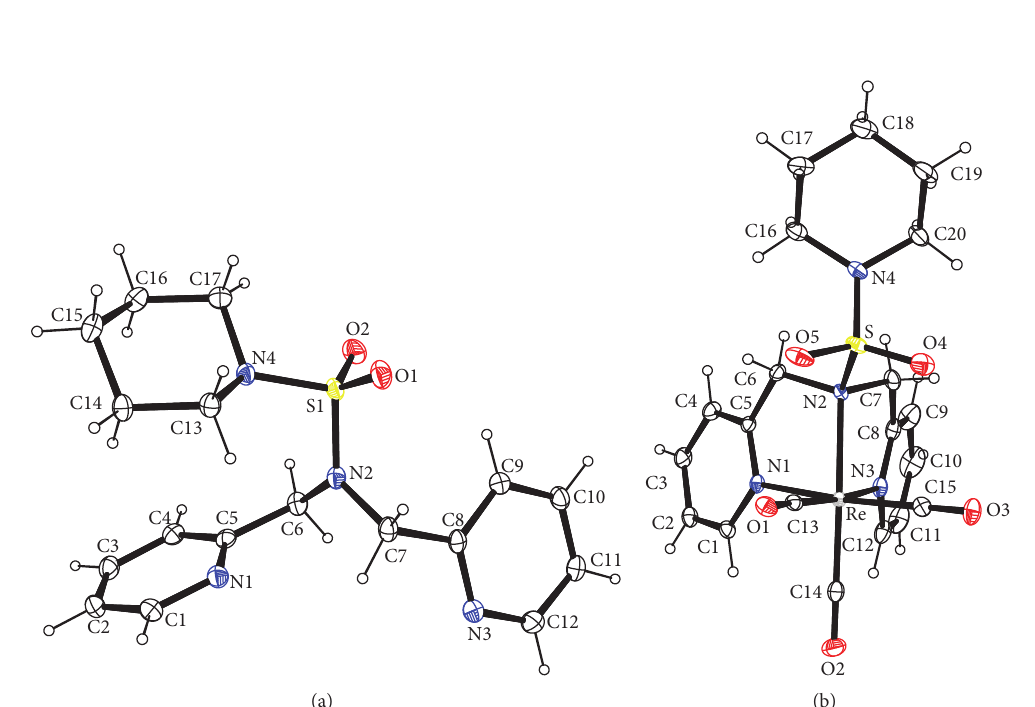
Figure 1: ORTEP plot of N(SO 2 pip)dpa (a) and the cation in [Re(CO) 3 (N(SO 2 pip)dpa)] + (b). Thermal ellipsoids are drawn with 50%